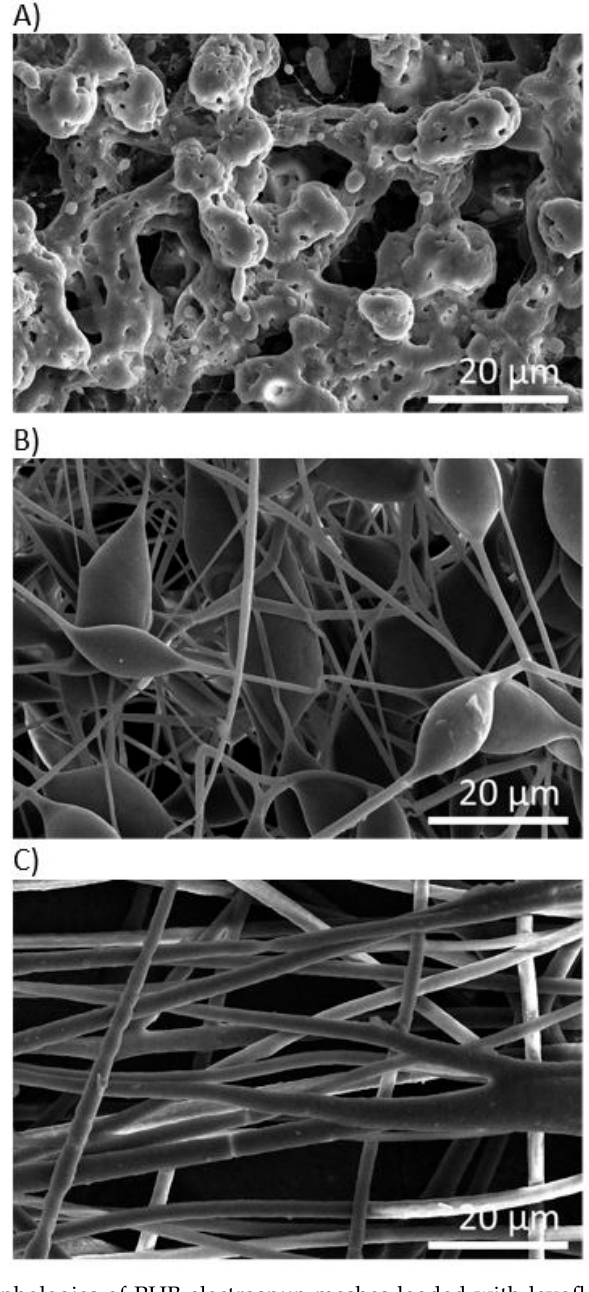
Figure 3. SEM morphologies of PHB electrospun meshes loaded with levofloxacin: ( A ) EM_1_L, ( B ) EM_4_L, ( C ) EM_5_L.